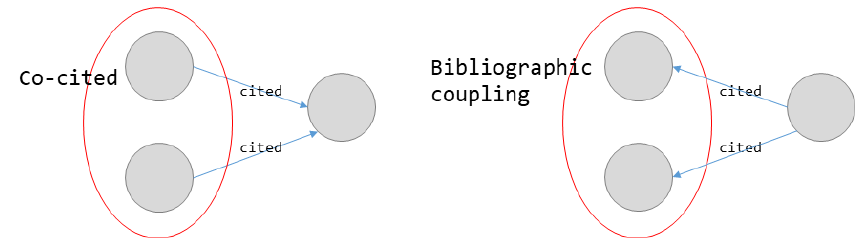
Figure 13. Co-cited vs. Bibliographic